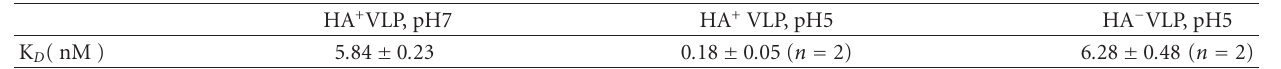
Table 2: Binding a ffi nity of antibody to